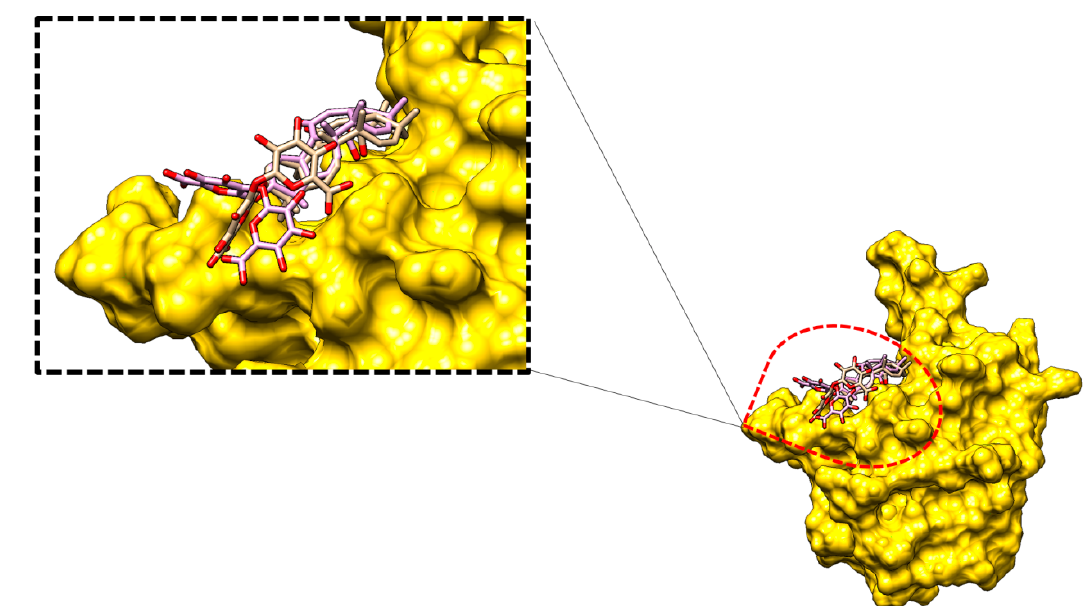
Figure 8. Binding mode dynamics of glycyrrhizin in the MD simulation at the initial time (in tan stick) versus at the end time (in plum stick).